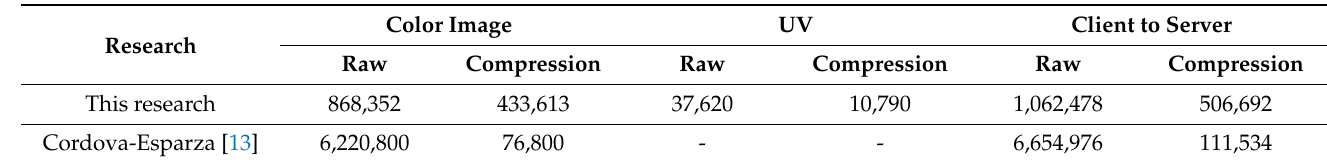
Table 2. Our proposed real-time 3D reconstruction compression result when sending to the server in